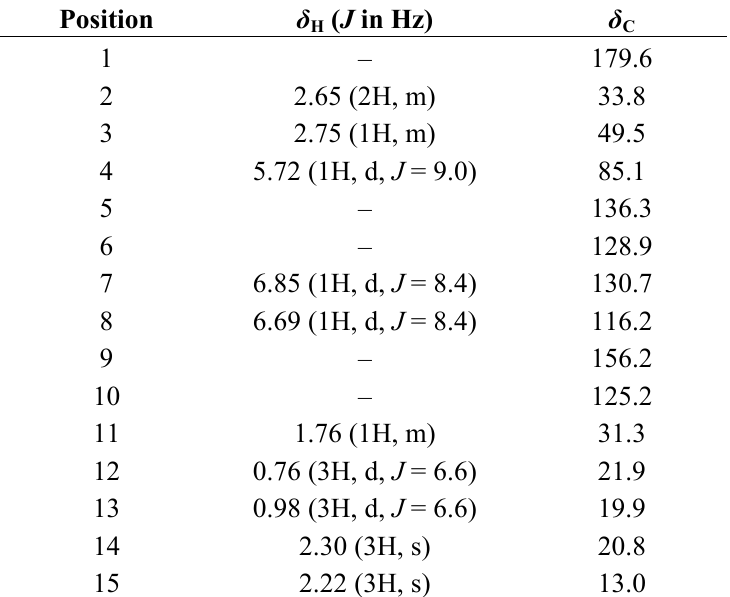
Table 4. 1 H-NMR (600 MHz) and 13 C-NMR (150 MHz) spectra data of compound 5 OD, J in Hz, δ in (in CD 3